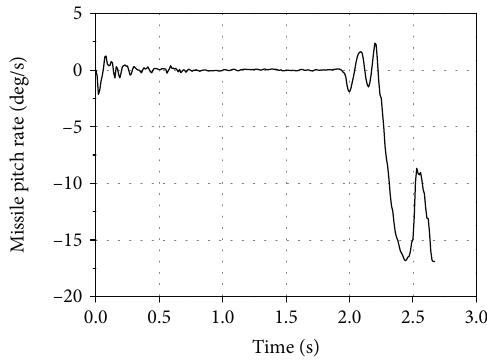
Figure 19: The pitch angular velocity of the missile under the fl uctuating